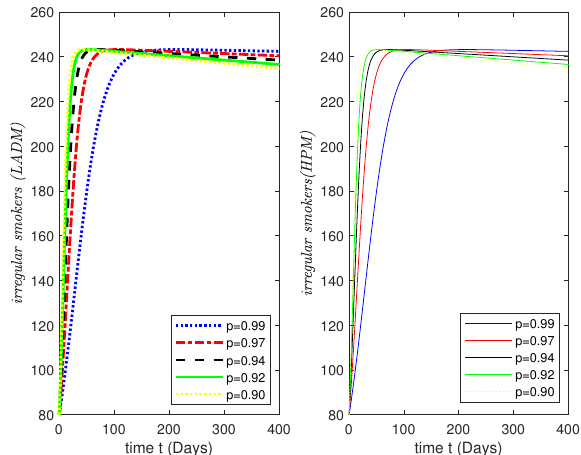
Figure 13. Comparison of the approximate solution for H ( t ) class of the proposed model having initial condition 100.